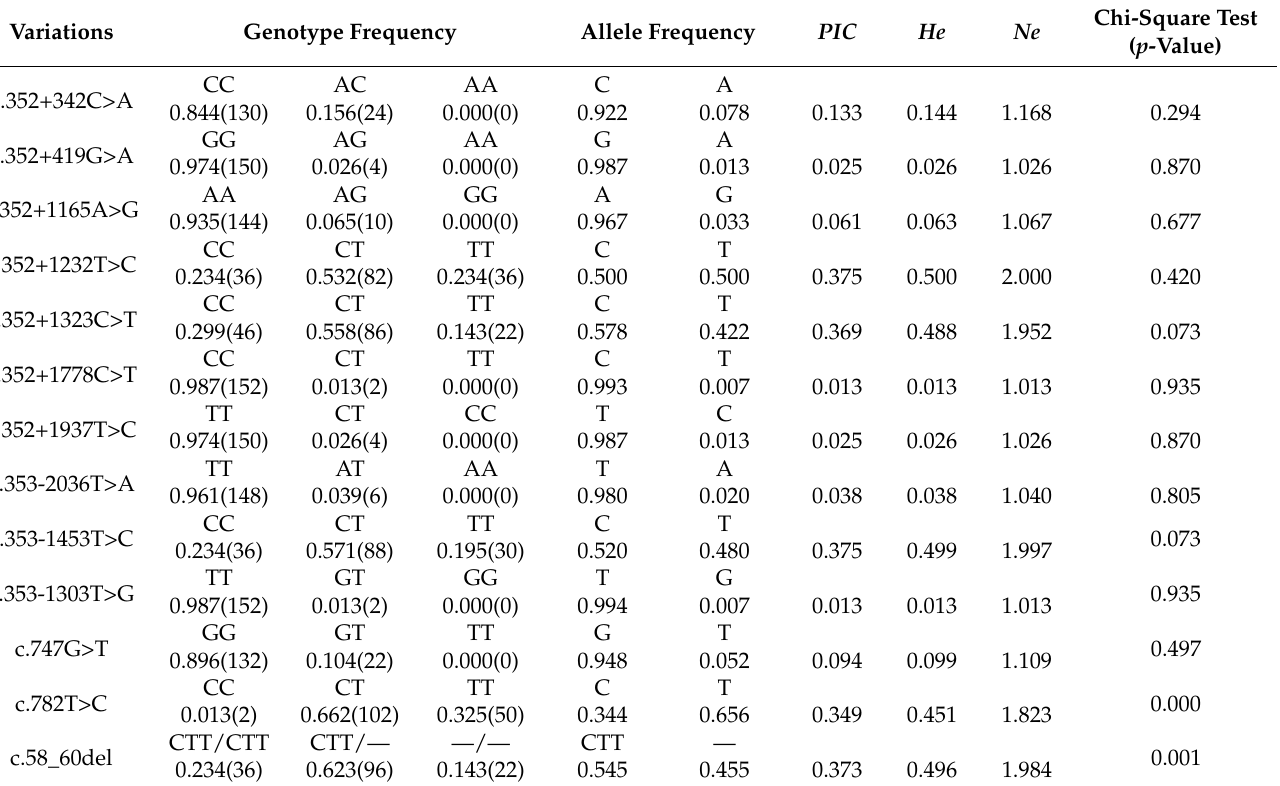
Table 3. Population genetic analysis for variations of BMP15 in Luzhong mutton